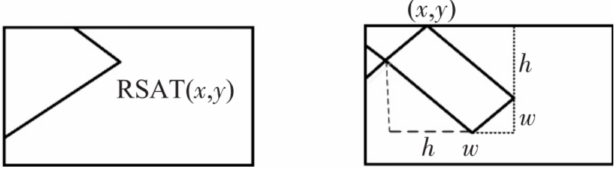
Figure 6. Rectangular integral diagram with an inclination of 45 ◦